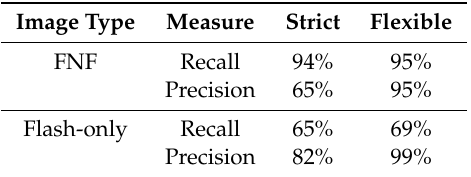
Table 4. Performance evaluation of the color-based algorithm across the entire dataset, when pepper clusters are considered successful detections.